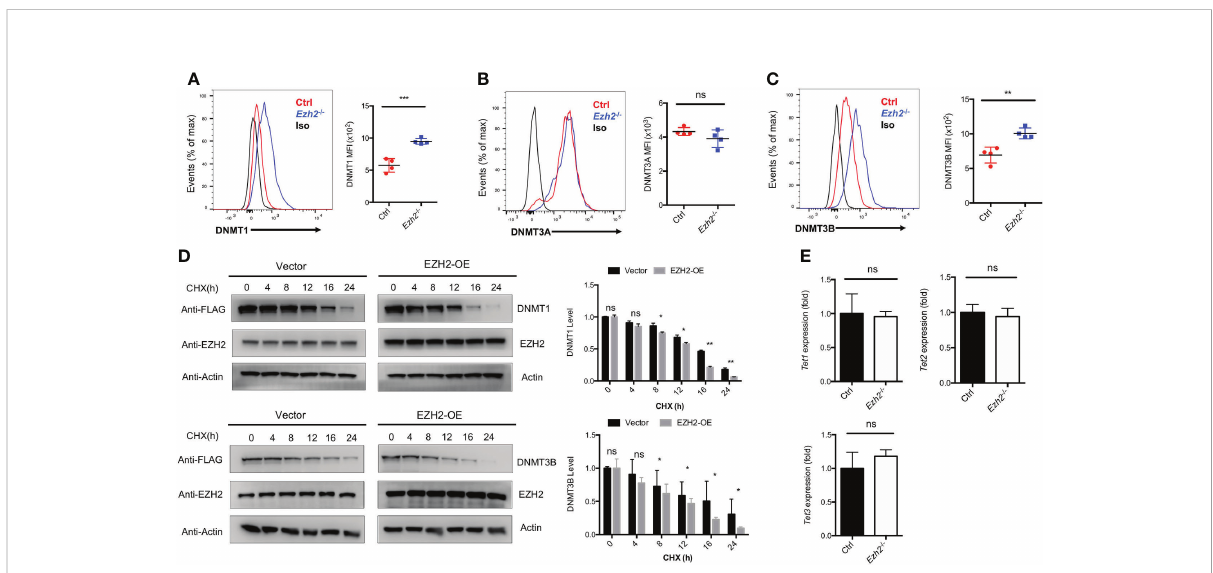
FIGURE 2 EZH2 regulates the expression of DNA Methyltransferases in T FH cells. (A – C) Analysis and summary of the expression of DNMT1, DNMT3A, DNMT3B in T FH cells via fl ow cytometry from control and Ezh2 -/- mice at day 8 after infection, respectively. (D) The control and EZH2 overexpression-transfected 293T cells were treated with cycloheximide (CHX) at indicated times, followed by western blot analysis. Normalized the expression to the zero timepoint. (E) Real-Time PCR analysis of Tet1 , Tet2 , and Tet3 transcripts of T FH cells sorted from infected control and P value was calculated by unpaired two-tailed Student ’ s t test from triplicate Ezh2 -/- mice. Normalized to their expression in control T FH cells. experiments. Error bars indicate mean ± SEM, ns not signi fi cant, * P < 0.05, ** P < 0.01, *** P <